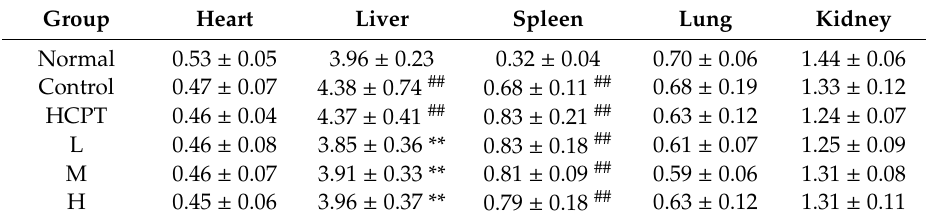
M 0.46 ± 0.07 Data are shown as mean ± SD, n = 10. # p < 0.05, ## p < 0.01 vs. Normal; * p < 0.05, ** p < 0.01, vs.